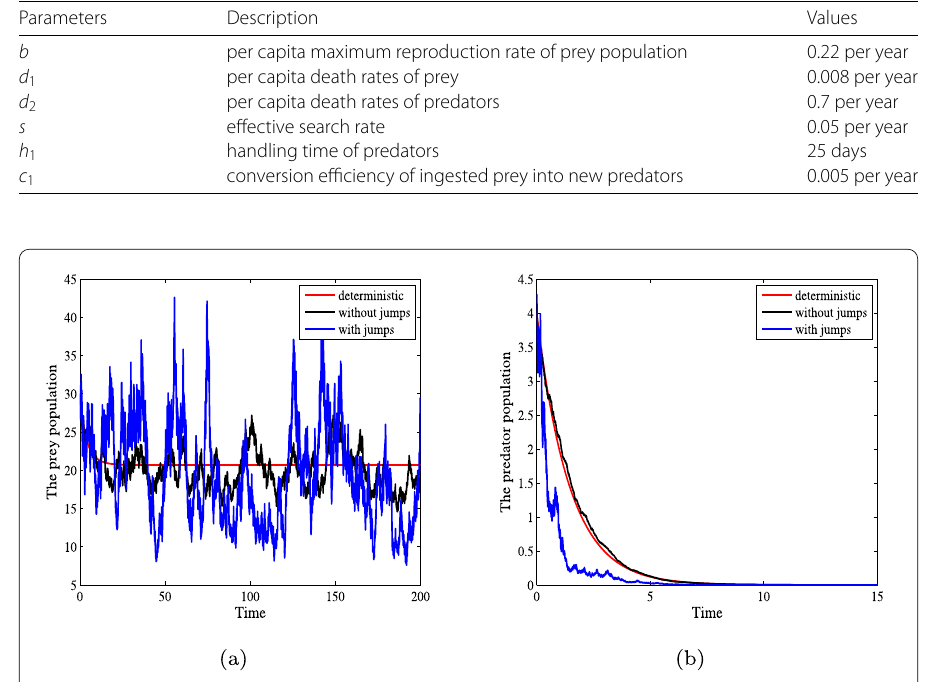
Figure 1 Deterministic and stochastic trajectories of prey population and predator population with parameters in Table 1. Moreover, σ 2 1 = σ 2 2 = 0.005 and γ 1 ( u ) = γ 2 ( u ) = 0.05. ( a ) Trajectories of prey population. ( b ) Trajectories of predator population. (Color figure